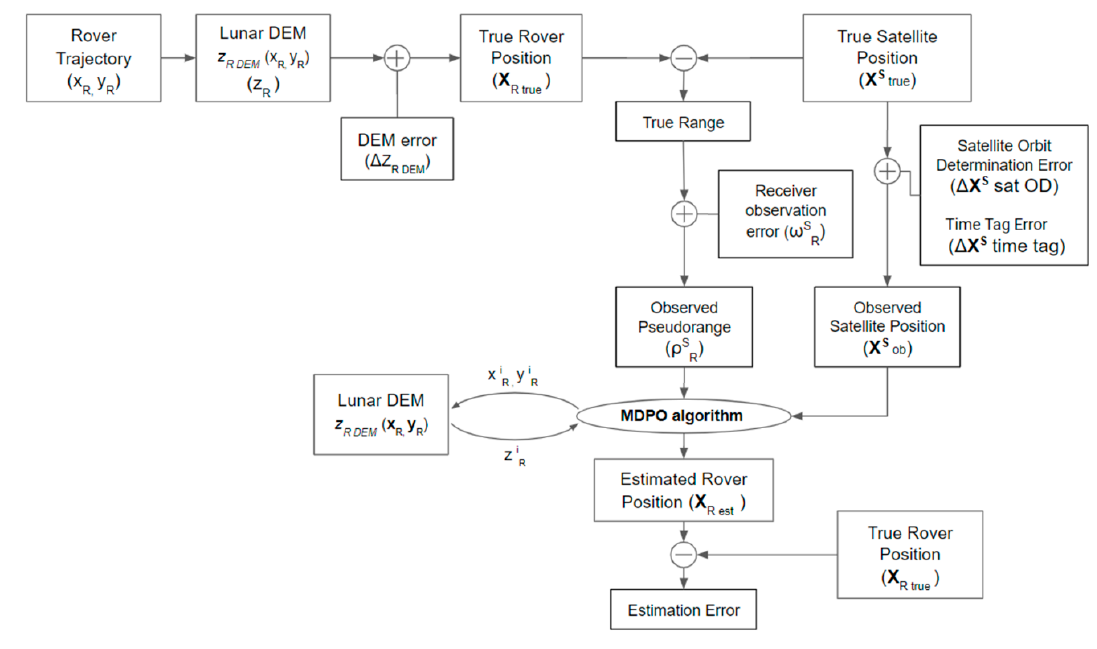
Figure 3. Simulation overview. Table 2. Simulation parameters.